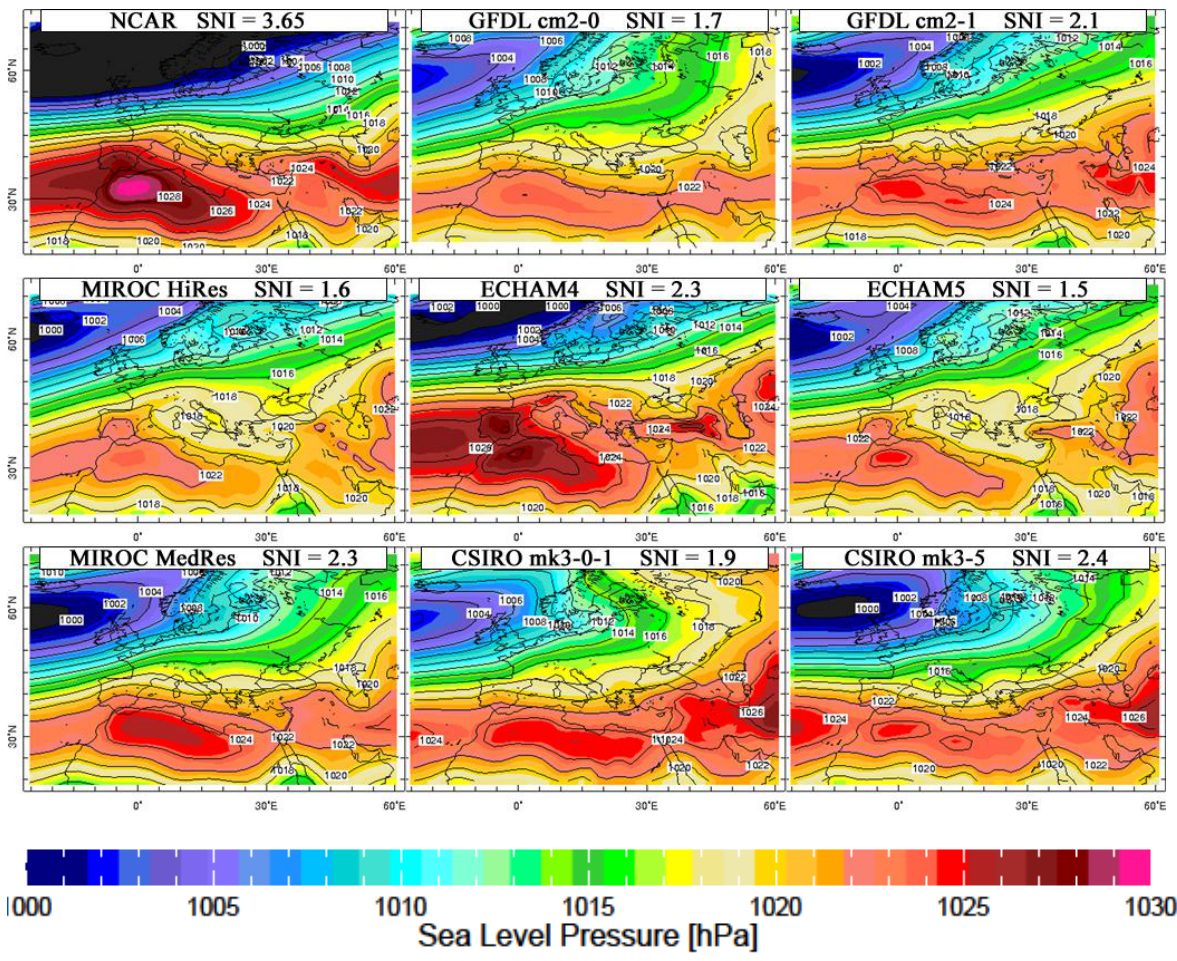
Fig. 6. As in Fig. 5, but for the 9 study models. The names of the individual models and their corresponding south–north pressure-difference index (SNI) are denoted above the respective